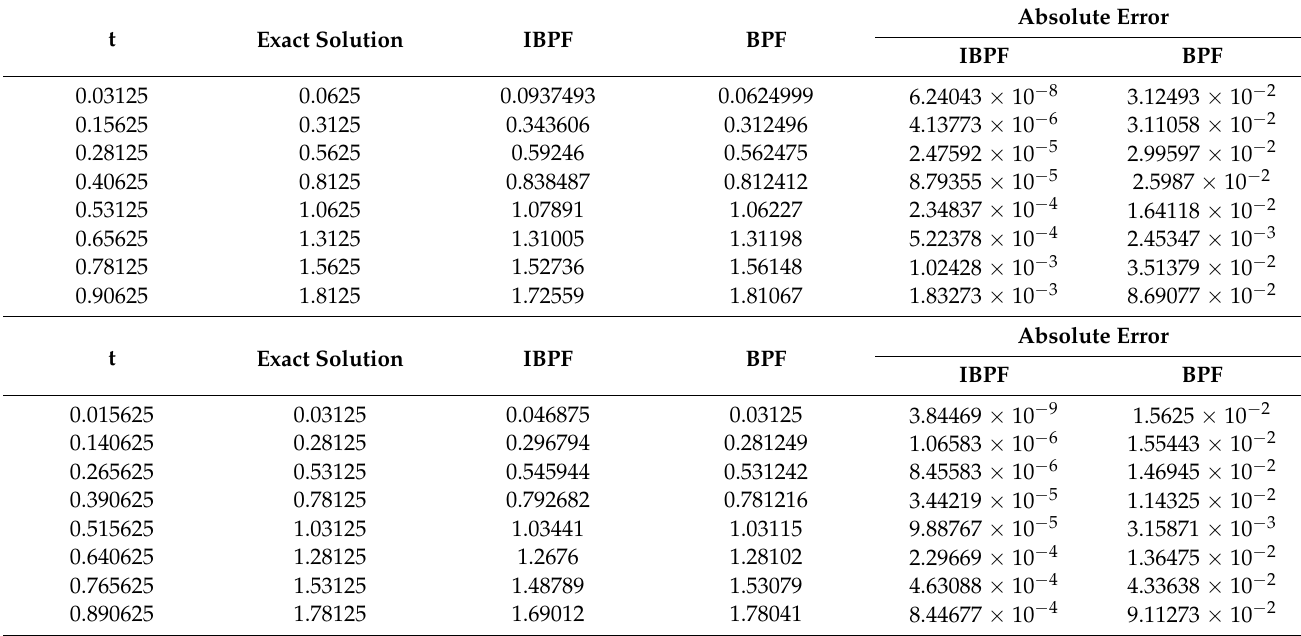
Table 3. The numerical results of example 3 at m = 32 and